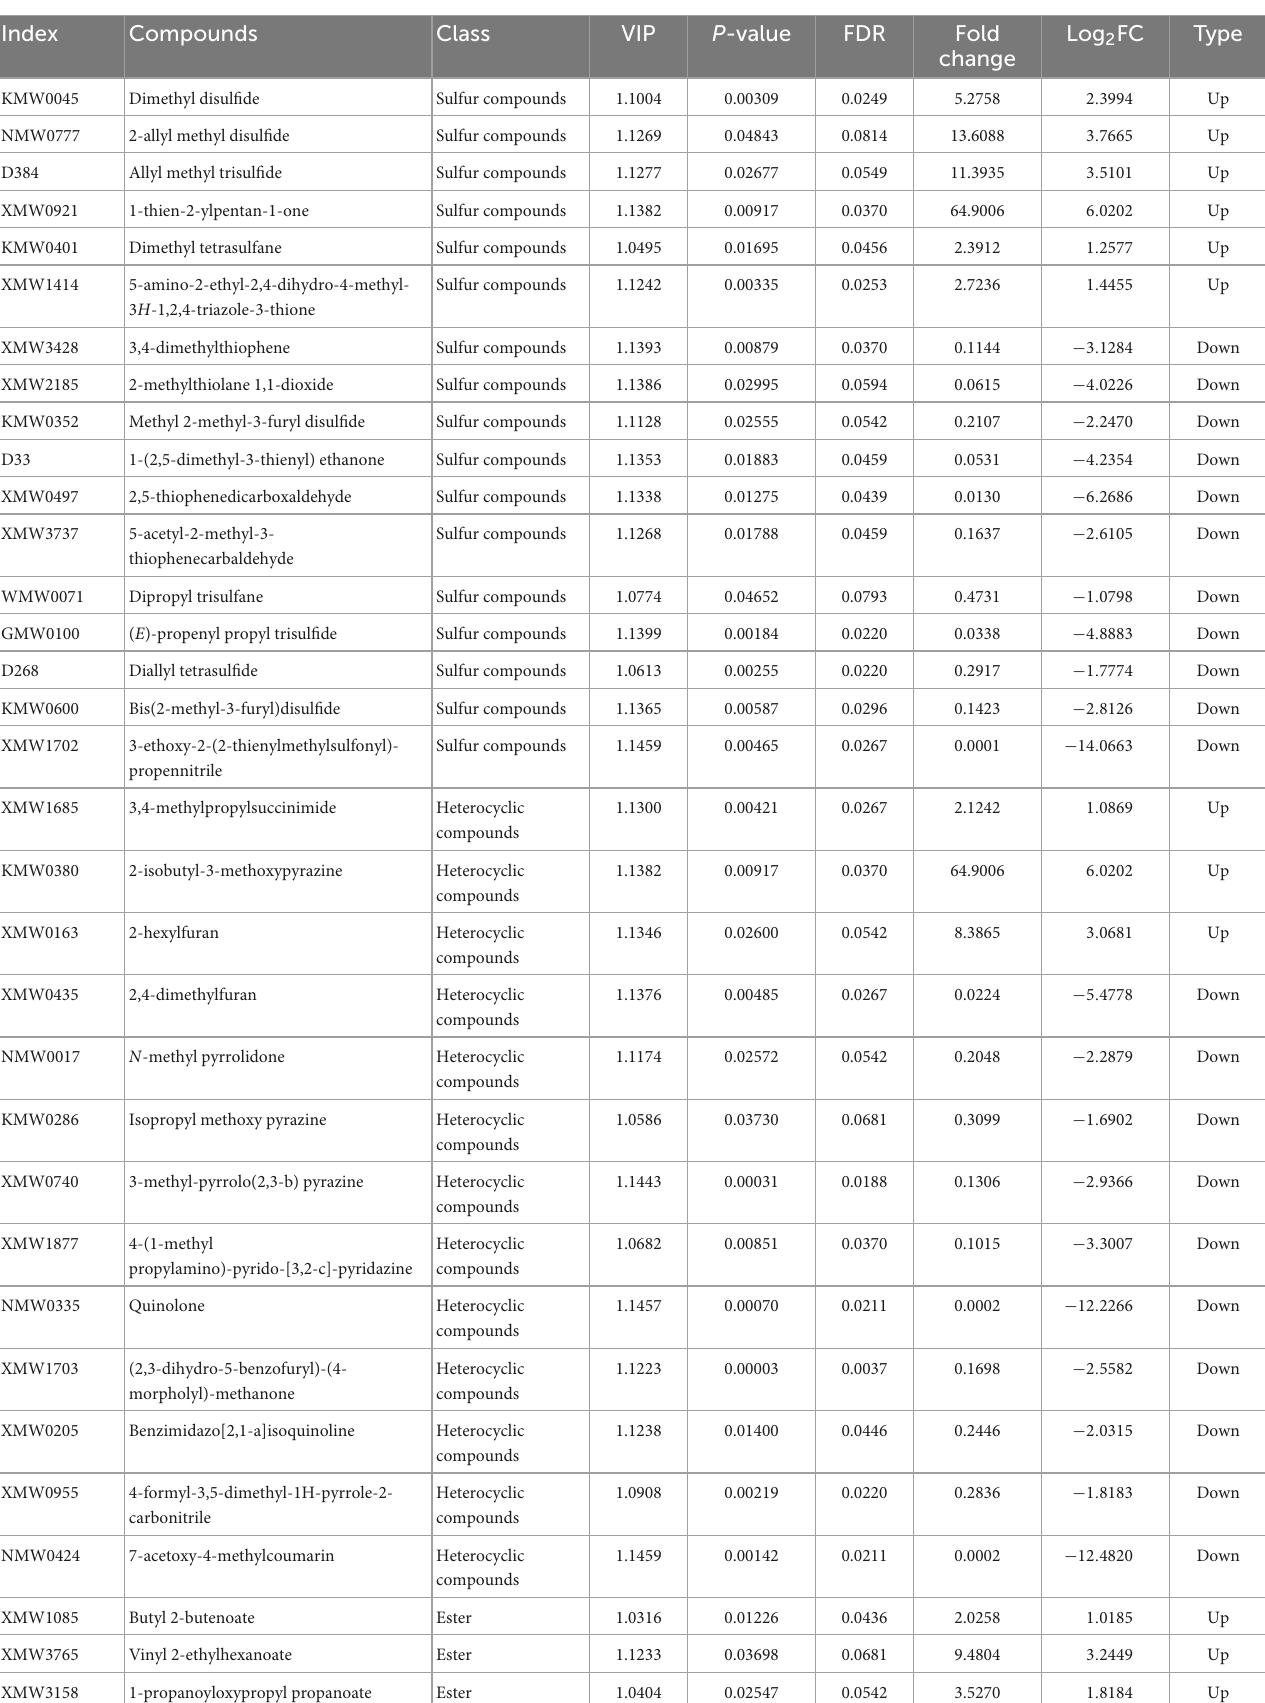
TABLE 1 The details of 62 differential volatile organic compounds (VOCs) between the volatile oils derived from the fresh bulbs of Allium macrostemon Bge. (AMB) and Allium chinense G. Don